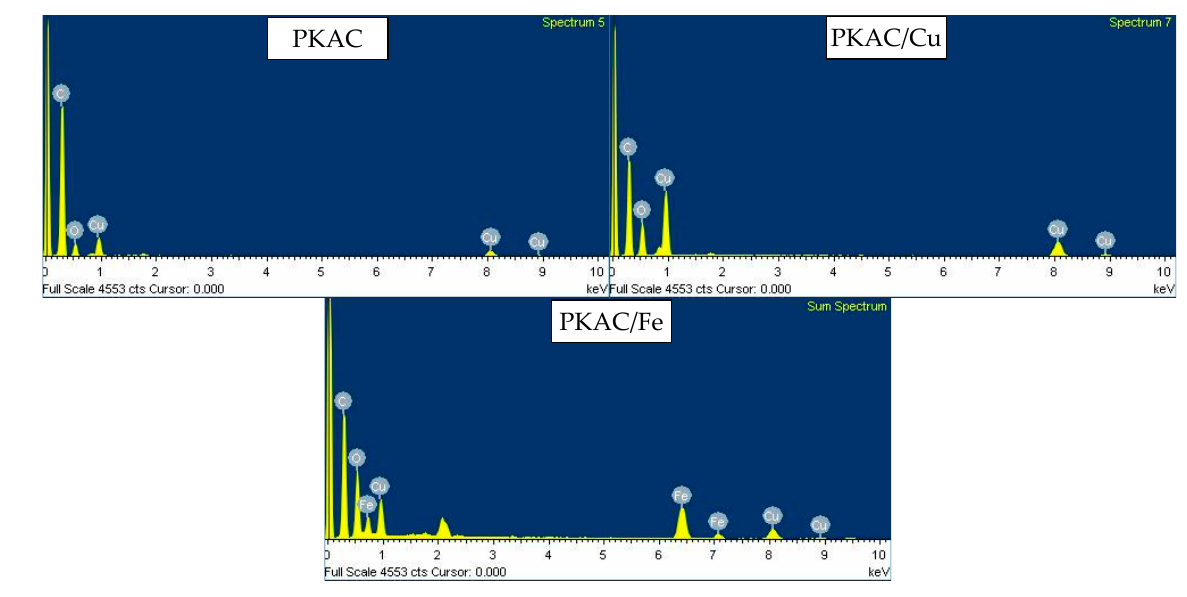
Figure 2. EDX spectra for PKAC and the monometallic catalysts at 100 magnification.